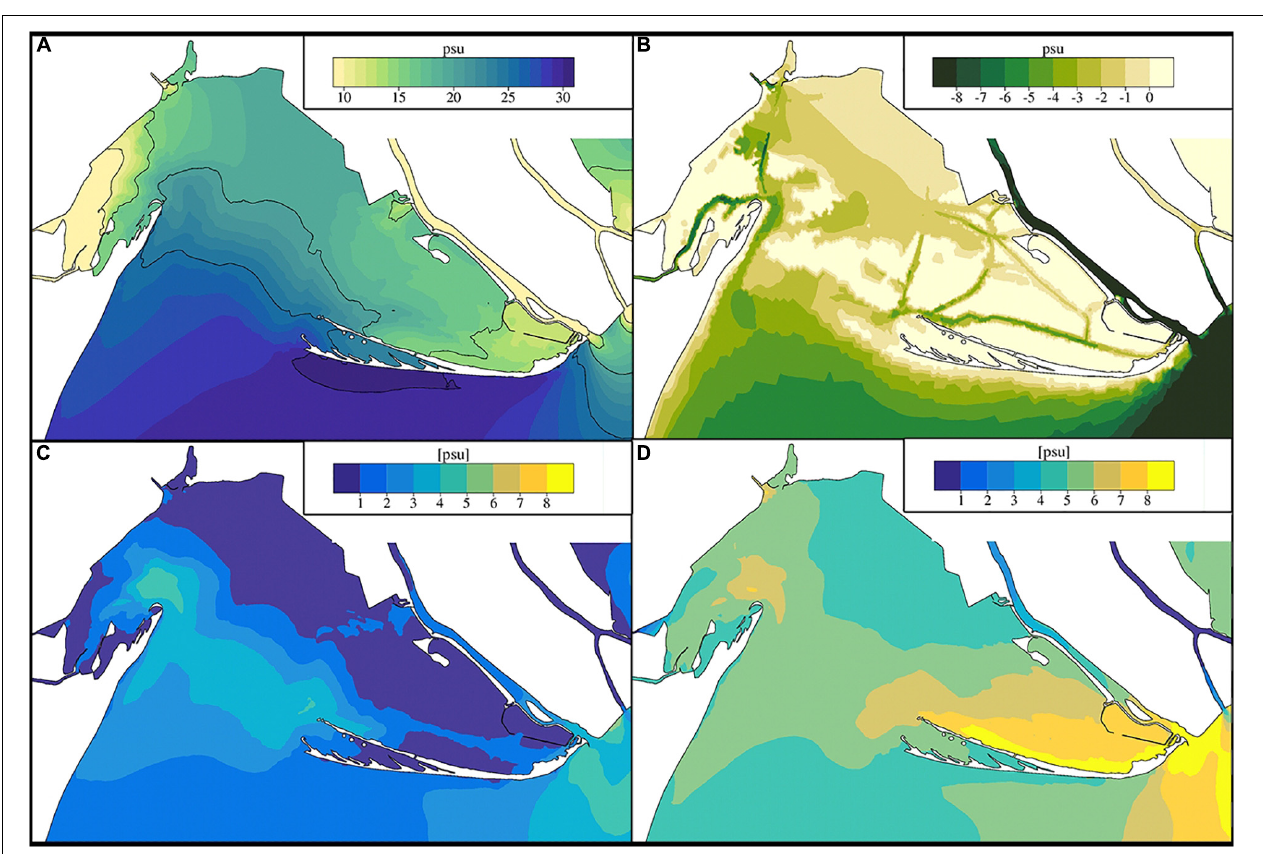
FIGURE 8 | (A) Average surface salinity and (B) salinity vertical stratification shown as the difference between surface and bottom salinity. (C) Daily and (D) yearly standard deviation of the surface salinity, calculated averaging over the 2018